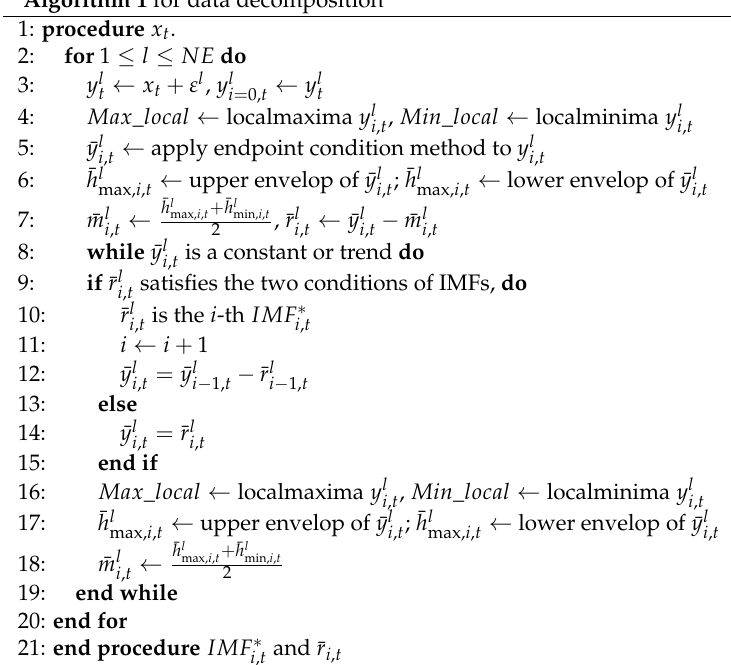
Algorithm 1 for data